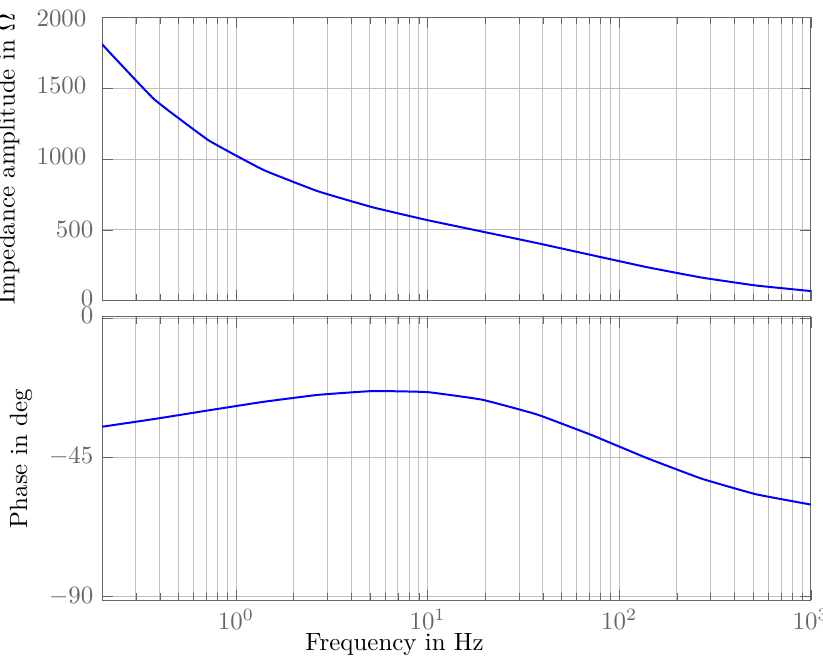
Figure 8. Bode plot of the impedance amplitude and the phase of the hydrogel as the result of the performed